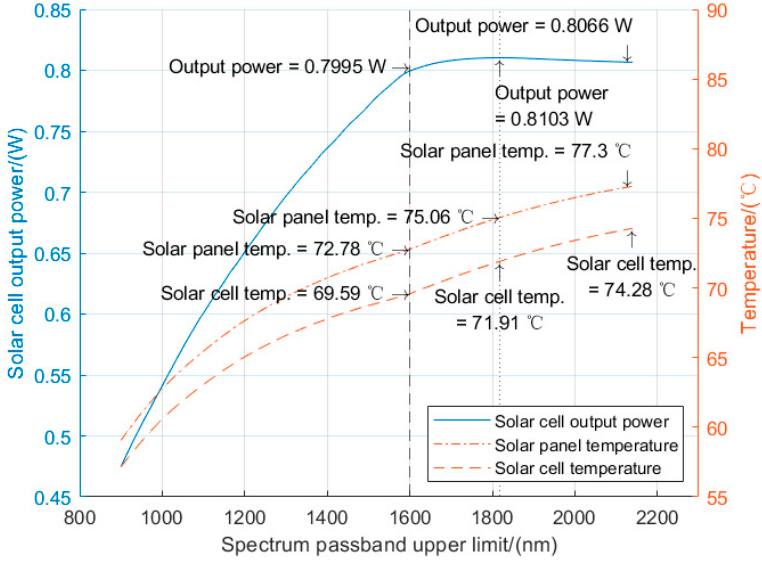
Figure 5. Relationship between the solar irradiation spectrum passband and solar cell